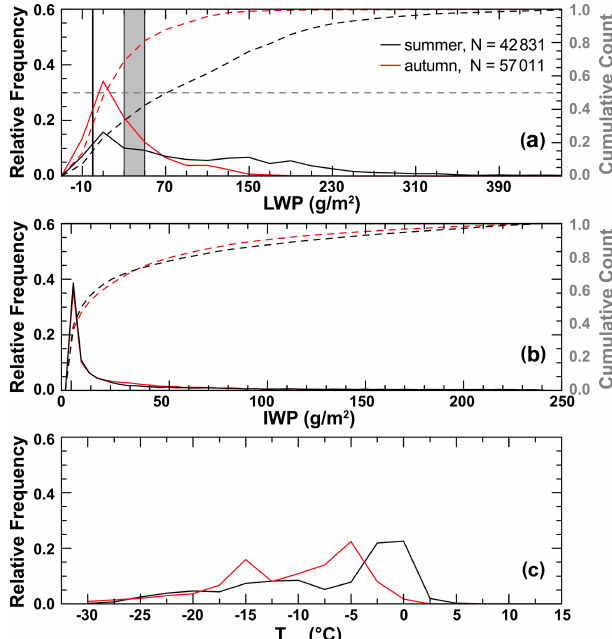
Figure 8. Histogram (solid lines) and cumulative count (dashed lines) of the occurrence frequency of liquid water path and ice wa- ter path as well as the histogram of the cloud-top temperature for mixed-phase clouds observed during summer (black) and autumn (red). Values give the number of considered cloud layers as ob- served on a profile basis. The grey dashed line in (a) marks 50% in the cumulative counts. The vertical line in (a) marks 0gm − 2 LWP while the grey area indicates the infrared black body limit between 30 and 50gm − 2